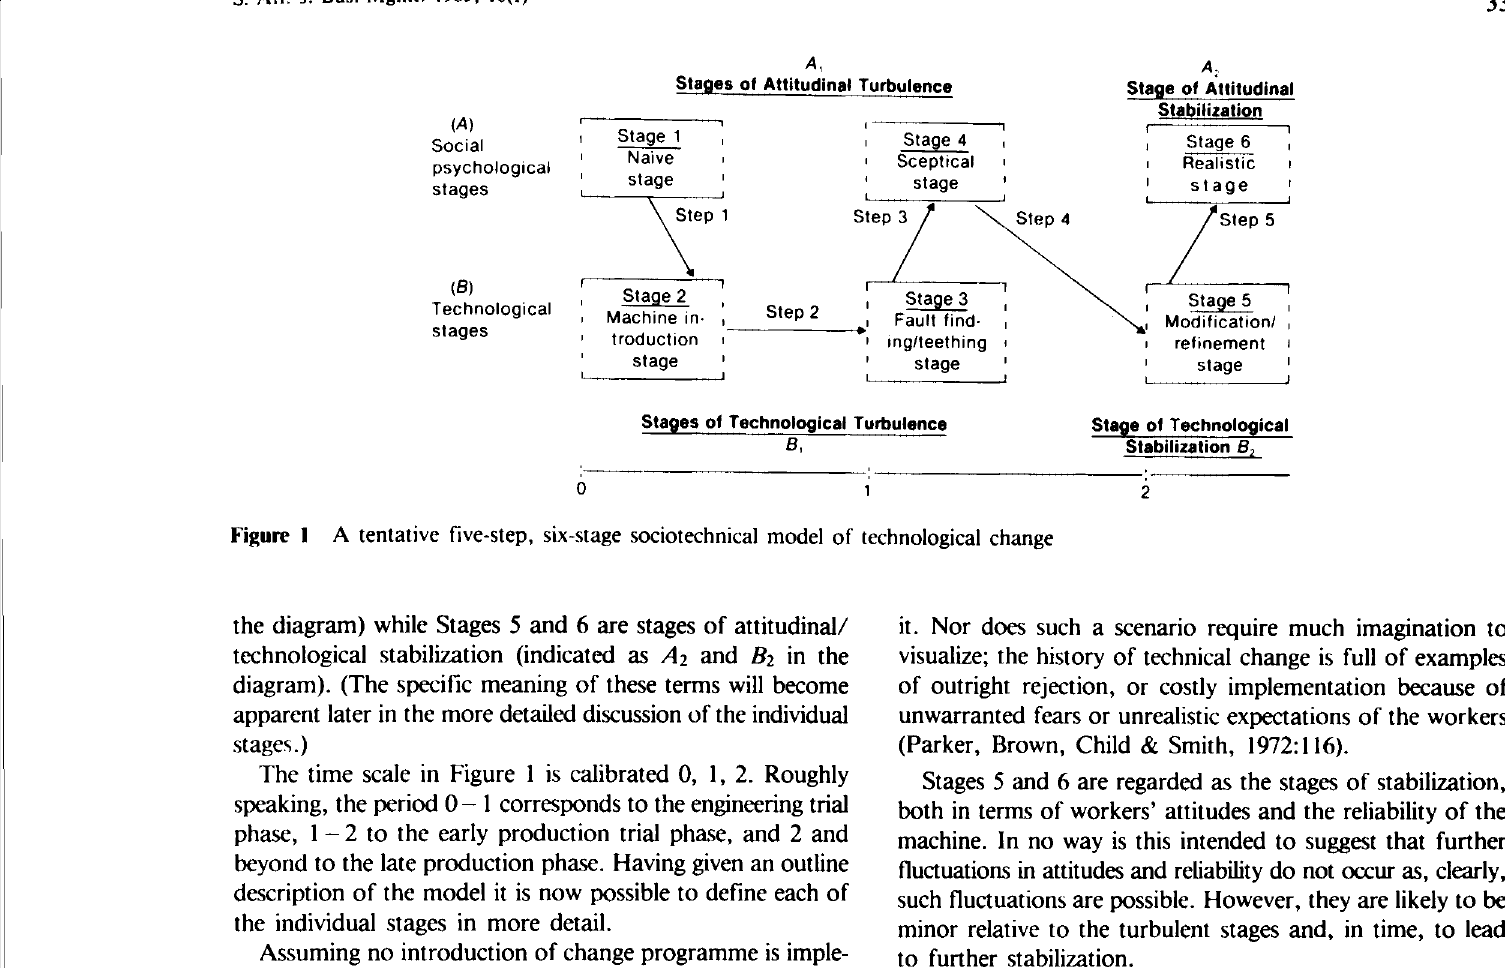
the diagram) while Stages 5 and 6 are stages of attitudinal/ technological stabilization (indicated as A2 and 82 in the diagram). (The specific meaning of these terms will become apparent later in the more detailed discussion of the individual